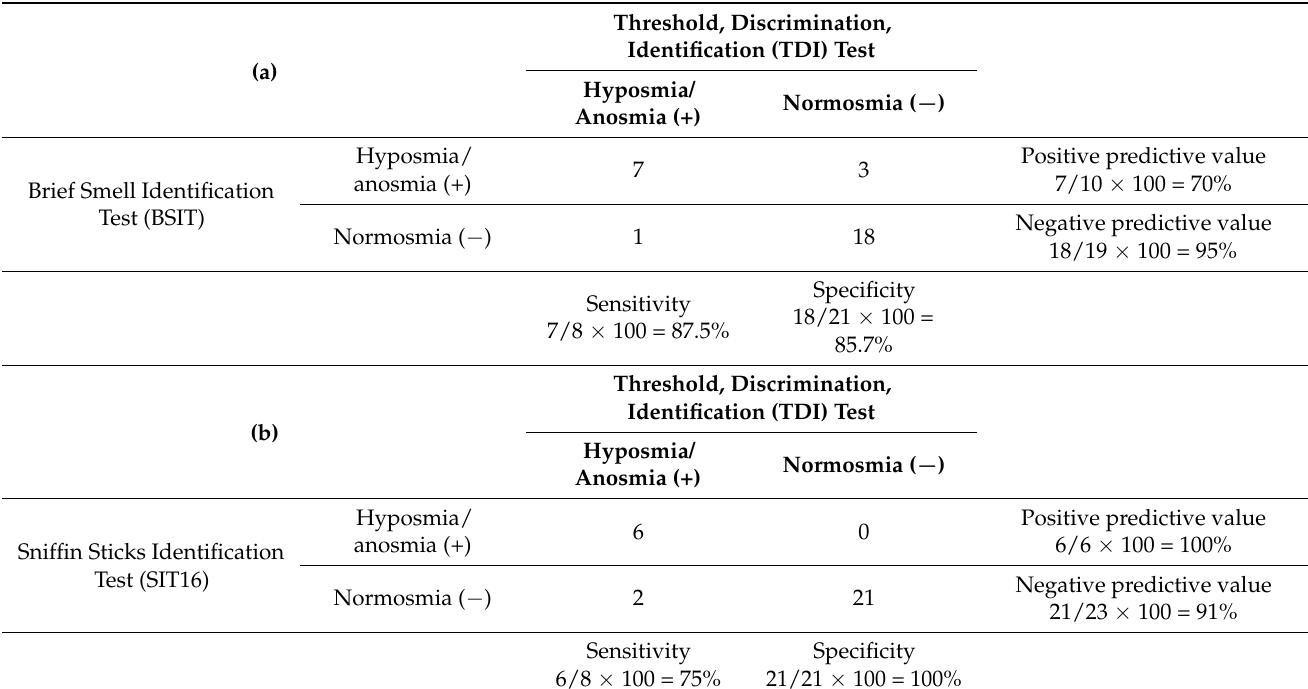
Table 4. a,b: Sensitivity and specificity for BSIT and SIT16 psychophysical identification tests compared with gold standard